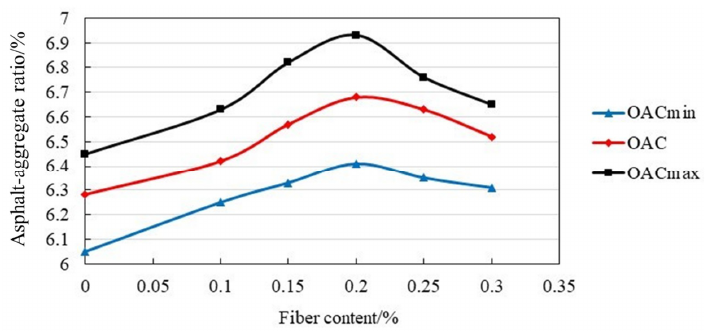
Figure 4. Relationship between fiber content and asphalt-aggregate ratio of SMA- Ⅱ -1.